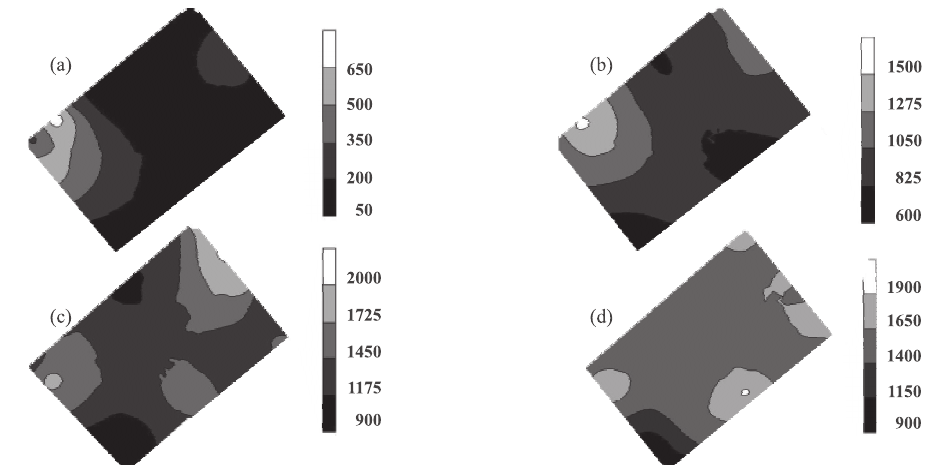
Figura 1. Mapas de krigagem para rp (kpa) nas camadas avaliadas: (a) 0,00–0,10 m, (b) 0,10–0,20 m, (c) 0,20–0,30 m e (d) 0,30–0,40 m.